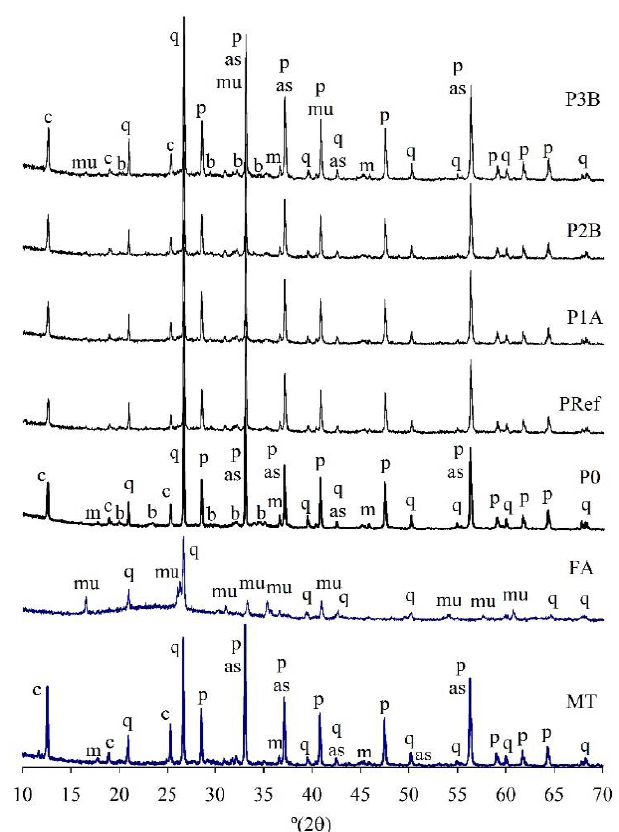
Figure 8. Diffractograms of the tailings, fly ash, and selected pastes (as, arsenopyrite: FeAsS; b, burkeite: Na 6 (CO 3 )(SO 4 )2; c, chamosite: (Fe 2+ ;Mg; Fe 3+ ) 5 Al(Si 3 Al)O 10 (OH;O) 8 ; mu, mullite: Al 6 Si 2 O 13 ; m, muscovite: KAl 3 SiO 10 (OH) 2 ; p, pyrite: FeS 2 ; q, quartz: SiO 2 ).